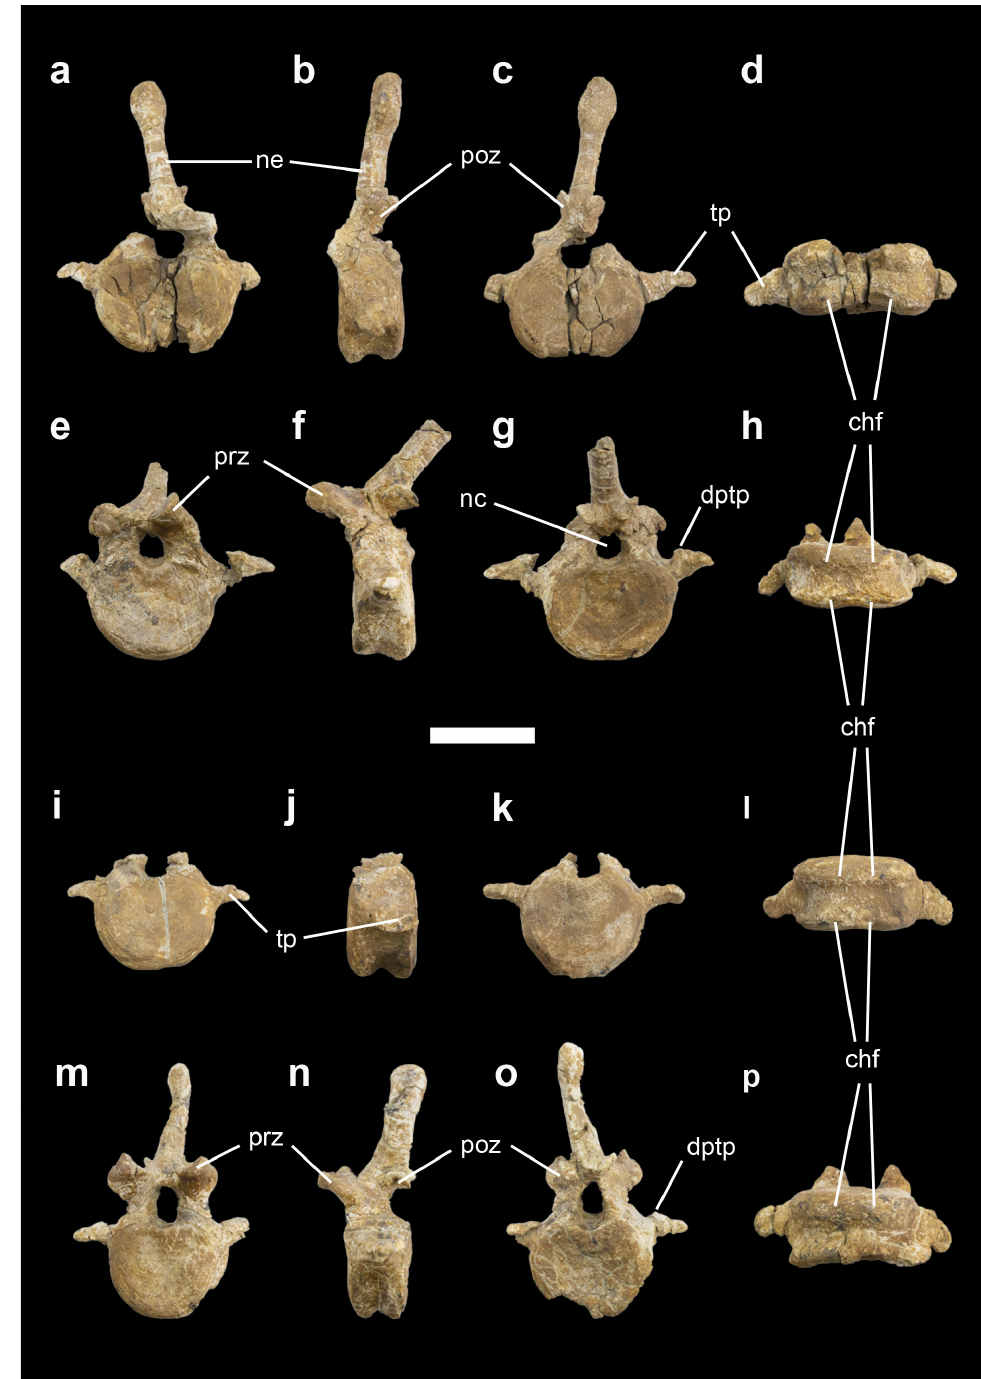
Figure 6. Caudal vertebrae from Barrihonda-El Humero fossil site (Riodeva, Teruel, Spain). Anterior caudal vertebrae MAP-4682 ( a – d ) and MAP-4680 ( e – h ), middle caudal vertebrae MAP-4683 ( i – l ) and MAP-4681 ( m – p ) in anterior ( a , e , i , m ), lateral ( b , f , j , n ), posterior ( c , g , k , o ) and ventral ( d , h , l , p ) views. Abbreviations: chf: chevron facet; dptp: dorsal process of the transverse process; nc: neural canal; ne: neural spine; poz: postzygapophyses; prz: prezygapophyses; tp: transverse process. Scale bar = 10 cm.